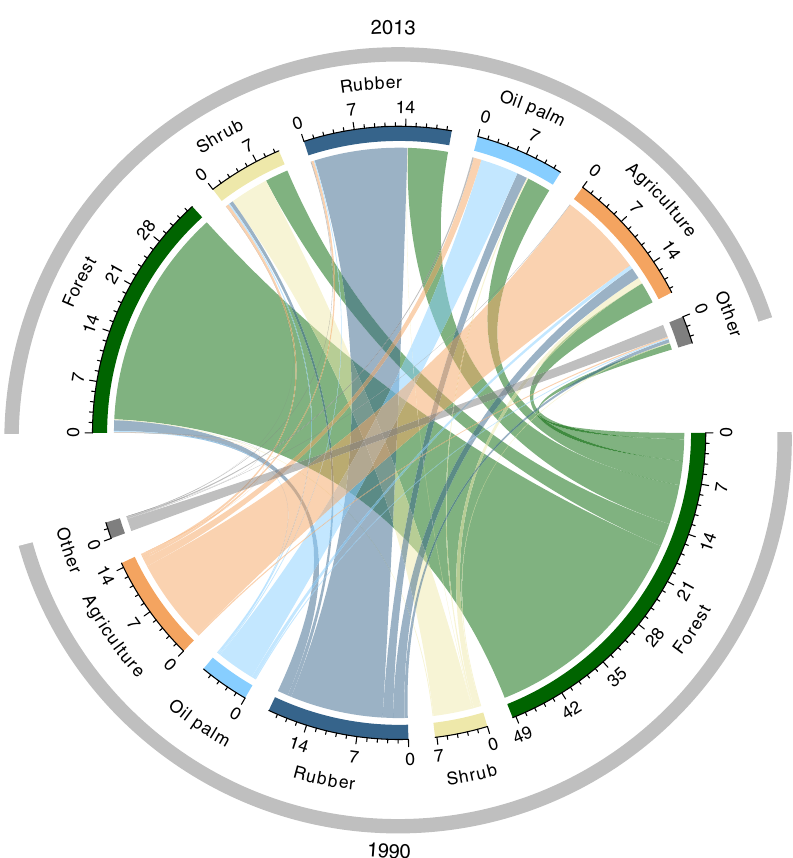
Fig. 1 Land cover changes and agricultural transitions (%) from 1990 to 2013 in Jambi Province (Sumatra, Indonesia). Note that rubber contains both land cover by jungle rubber and rubber monoculture plantations, as these could not be clearly distinguished by remote sensing. Colored fl ows show pathways of land-use transitions from 1990 to 2013, excluding intermediary steps (e.g., transitions from rainforest to shrub to oil